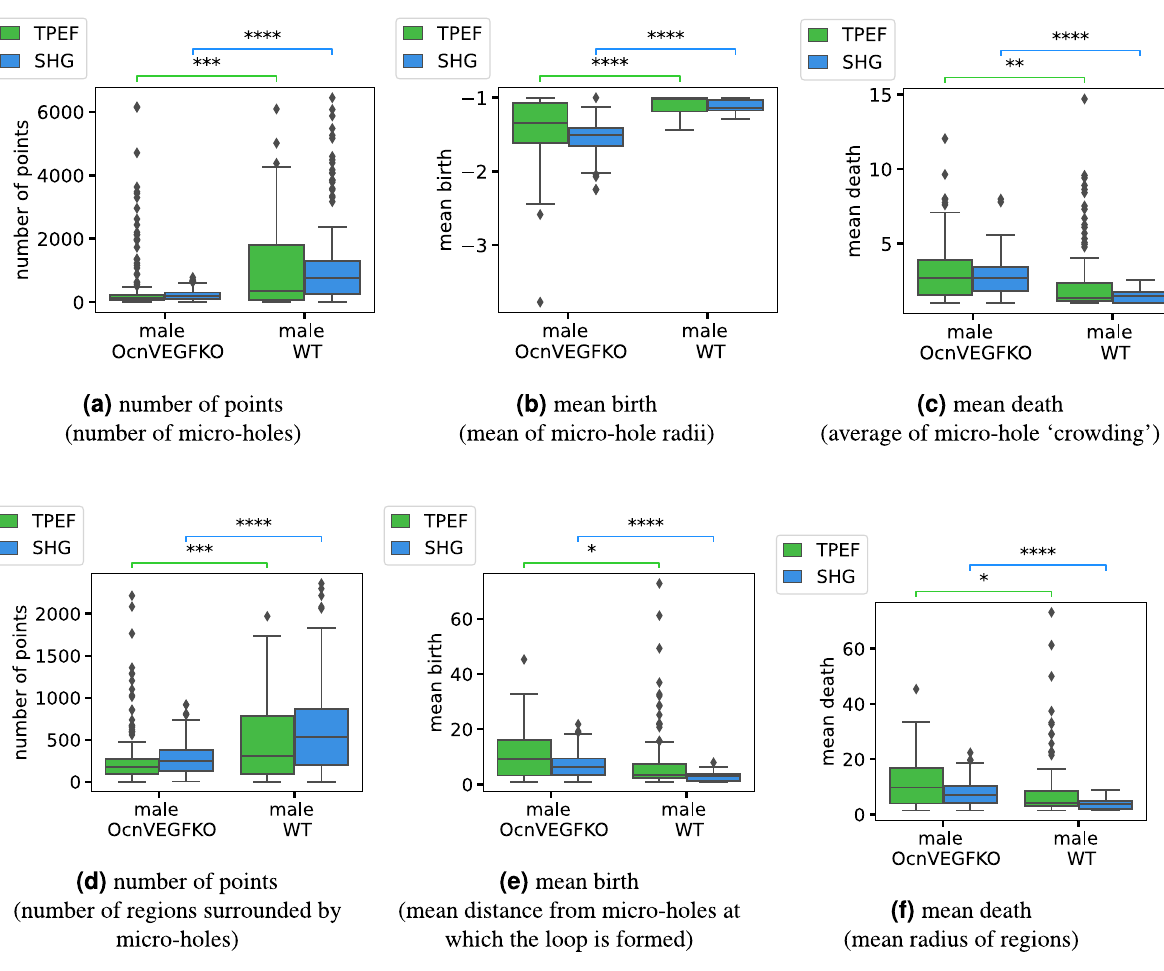
Figure 5. Box plots of persistence statistics per image patch, with three ( a – c ) from quadrant 2 of H 0